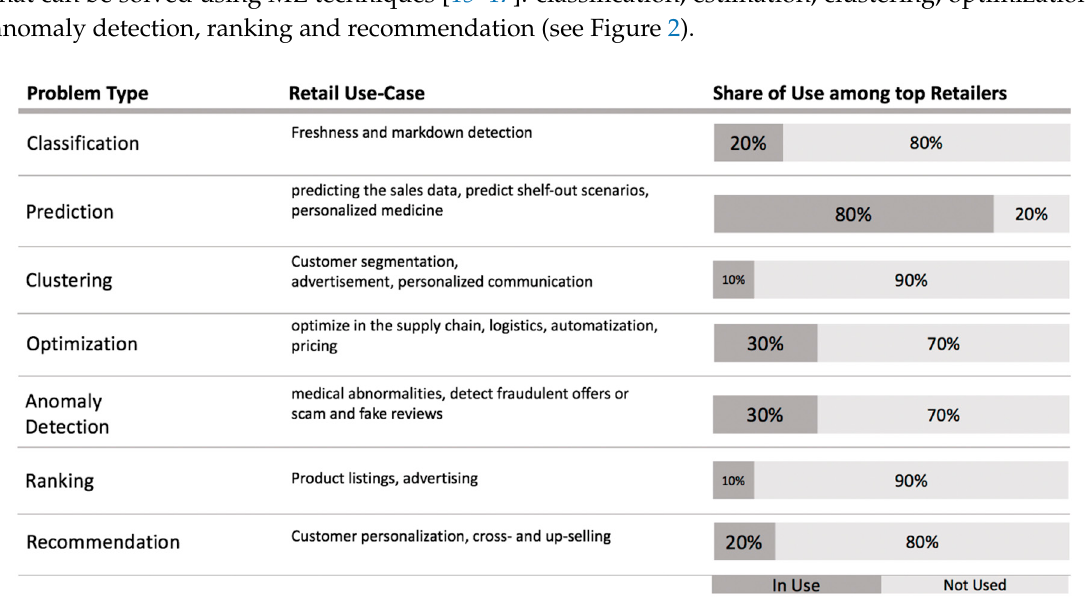
Figure 2. Overview of different problem types, the machine learning (ML) techniques to solve them, mapping use-cases and the diffusion within the largest retail companies.